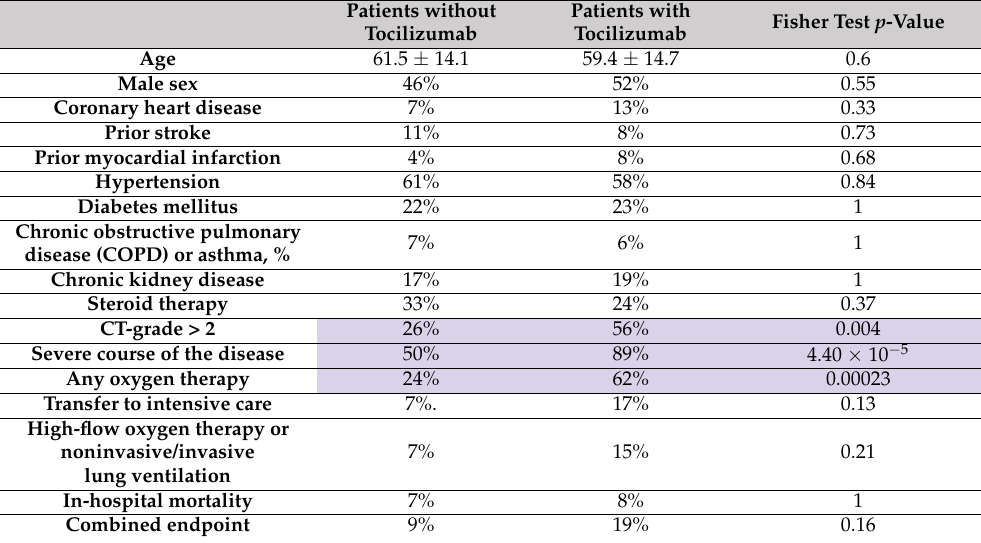
Table 3. Comparison of clinical parameters and outcomes between subgroups of patients with and without tocilizumab therapy. p -values are presented according to the Fisher exact